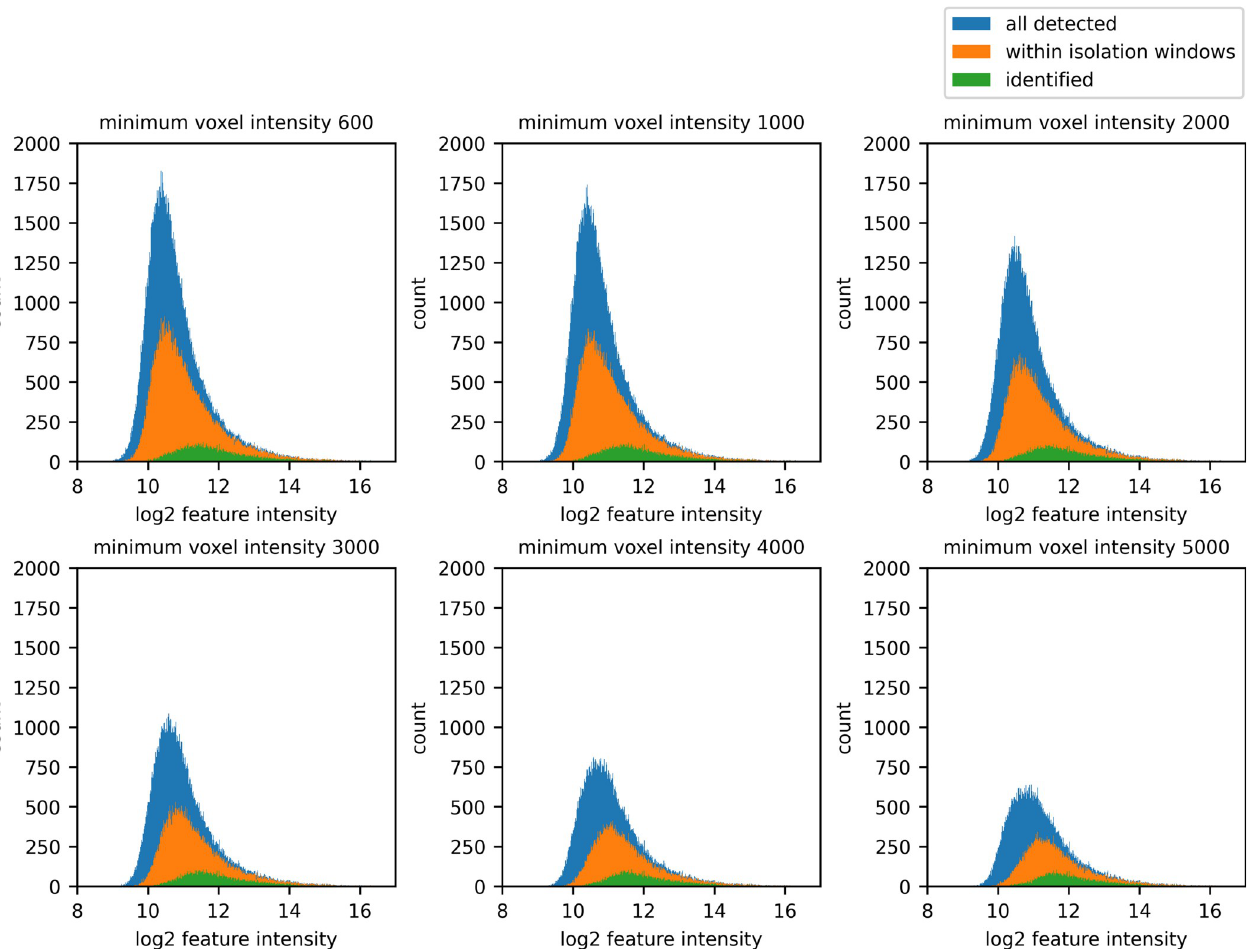
Fig 10. Reducing the minimum voxel intensity increases the number of features detected overall—and within the isolation windows—at an intensity lower than what can be identified with the Comet/Percolator toolchain.